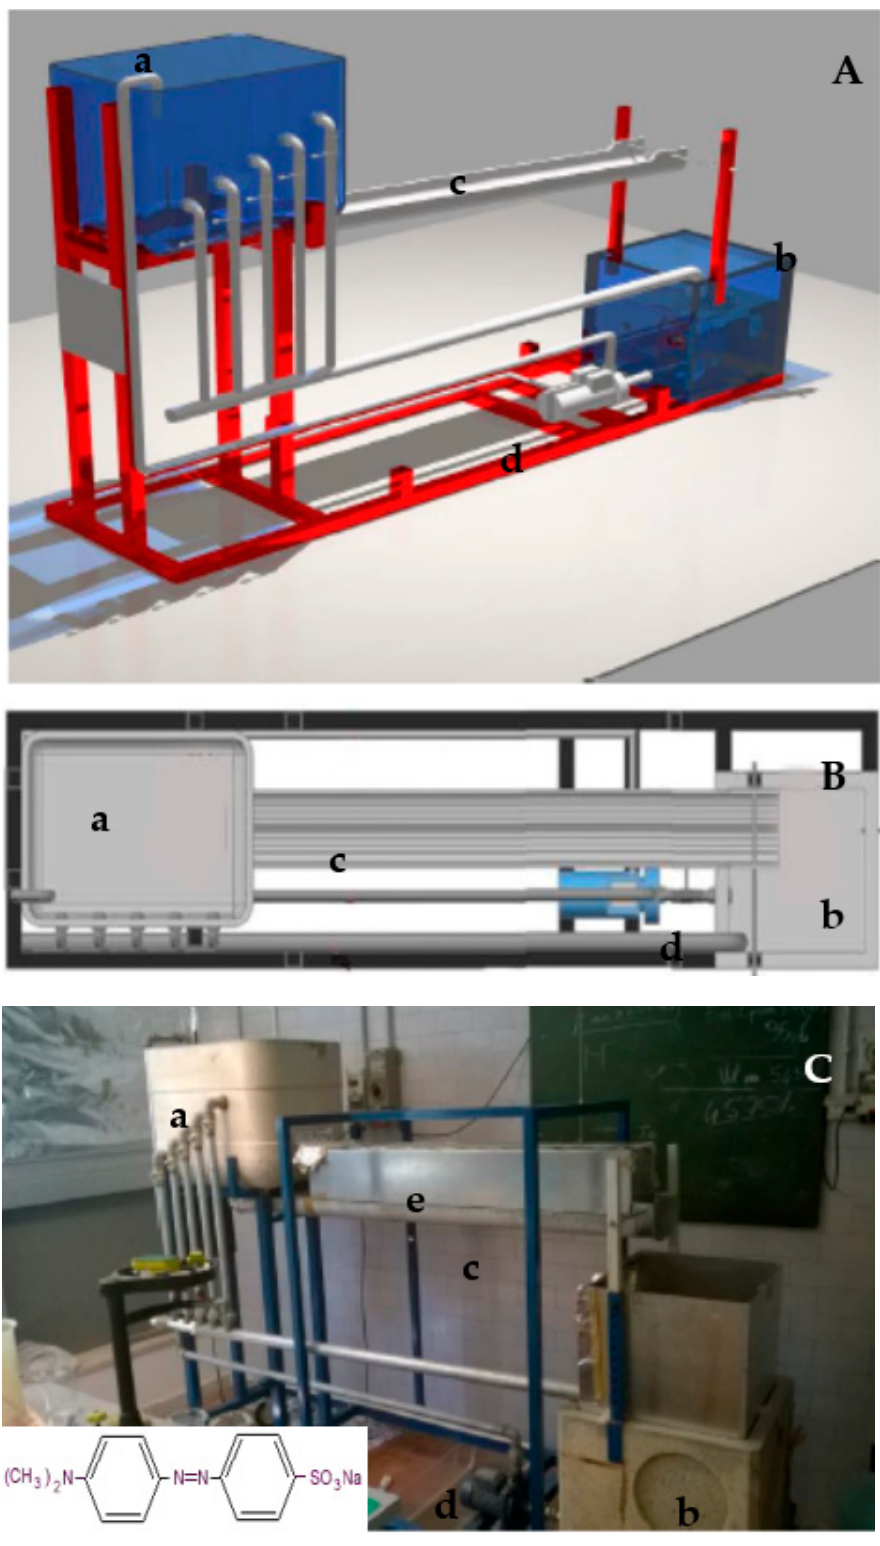
Figure 1. ( A ) Overview scheme and ( B ) top view scheme of the laboratory scale pilot plant. ( C ) Picture of the unit. (a) Upper reservoir, (b) bottom reservoir, (c) channel, (d) pump, (e) UVB lamp.